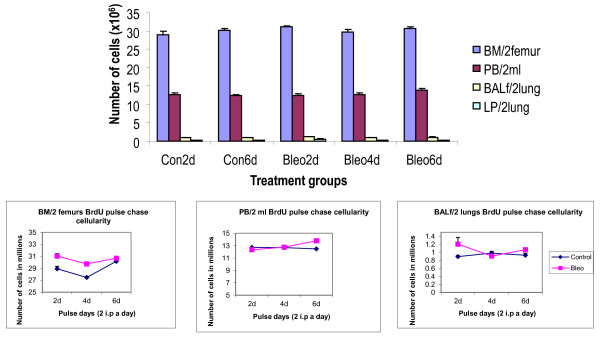
Cellularity in bone marrow, peripheral blood, lung parenchma and bronchoalveolar lavage fluid before and after bleomycin after 10 weeks of bromodeoxyuridine pulse chase. Total cell number in bone marrow, blood, lung and airways after 10 weeks of chase following12-hourly pulsing for up to 6 days in the saline-treated control mice (Con) and bleomycin-treated (Bleomycin) (one i.t. dose of 0.075 U/ml). P values < 0.05 compared to the control were considered significant. Data were averaged from three independent experiments. FACsans and flow sorts were done in triplicate per sample. Samples were counted in duplicate tubes per sample for each data point (n = four to five per group). Mortality was less than 2%. In this experiment no significant change was found in total cellularity. Abbreviations: BM, bone marrow; PB, peripheral blood; BALf, bronchoalveolar lavage fluid; LP, lung parenchyma; BrdU, bromodeoxyuridine.